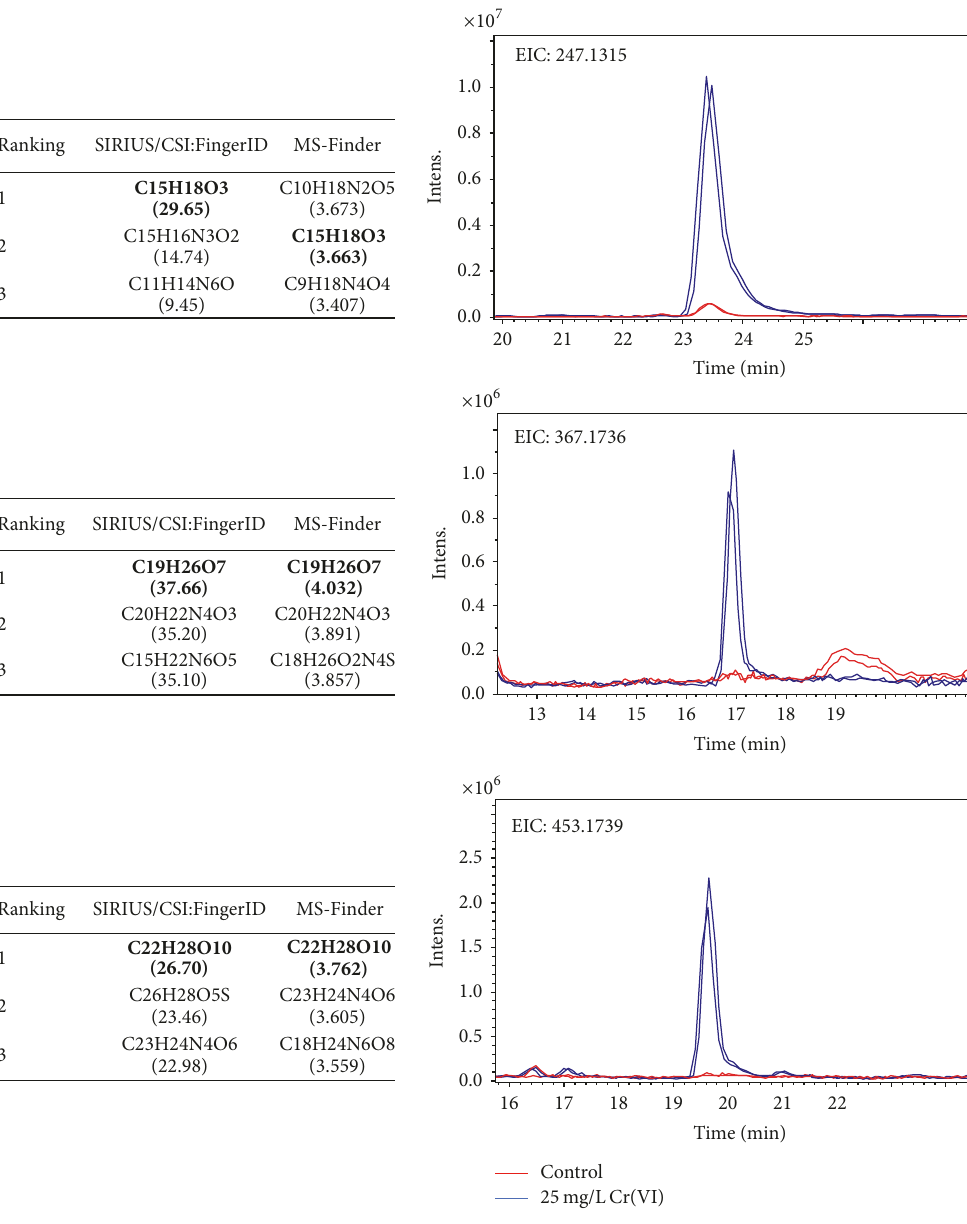
Figure 6: Three first molecular formulas predicted in SIRIUS and MS-Finder for seven precursor ions (score values reported in parentheses, bold font indicates the pondered formula) and the extracted ion chromatograms of these ions acquired for two replicates of exposed and nonexposed roots, respectively (see Table 1 for the description of